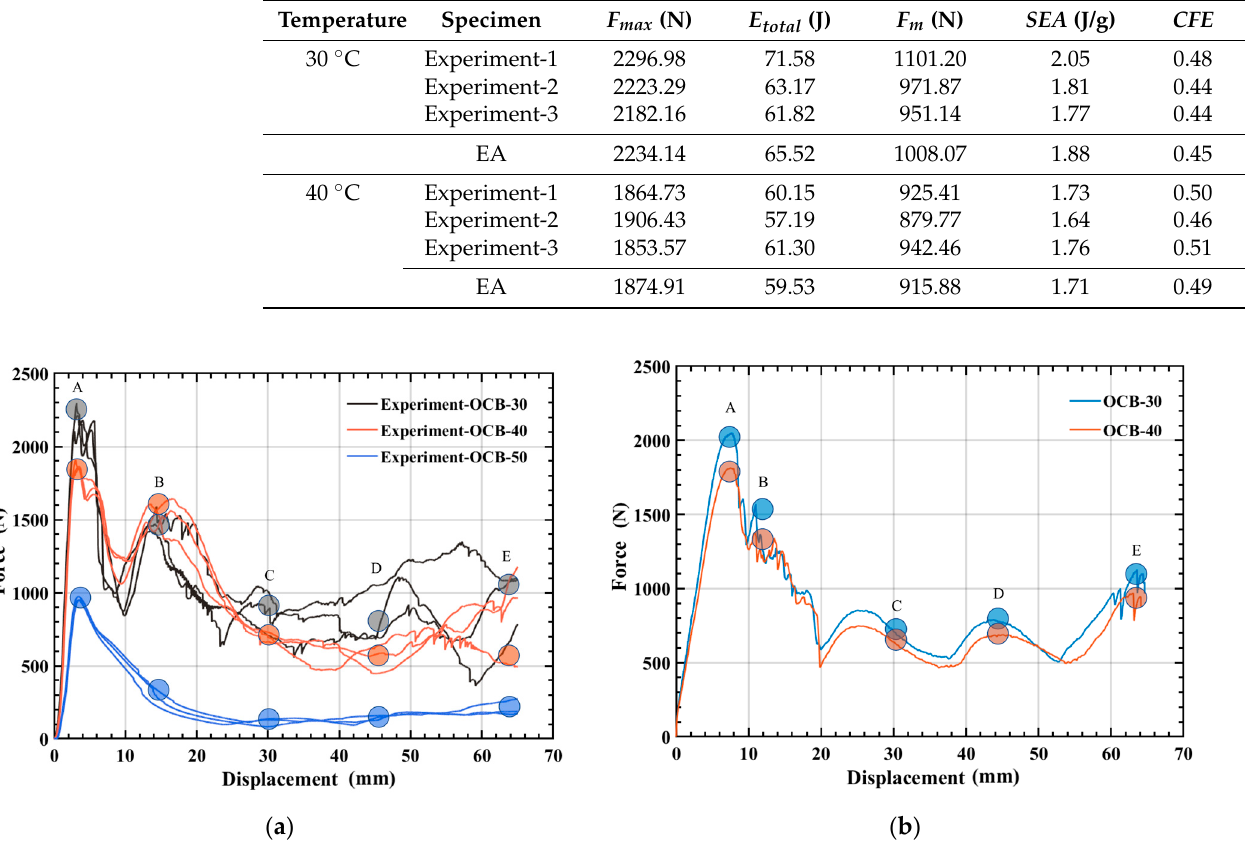
Table 4. Three sets of experimental data at 30 ◦ C and 40 ◦ C.